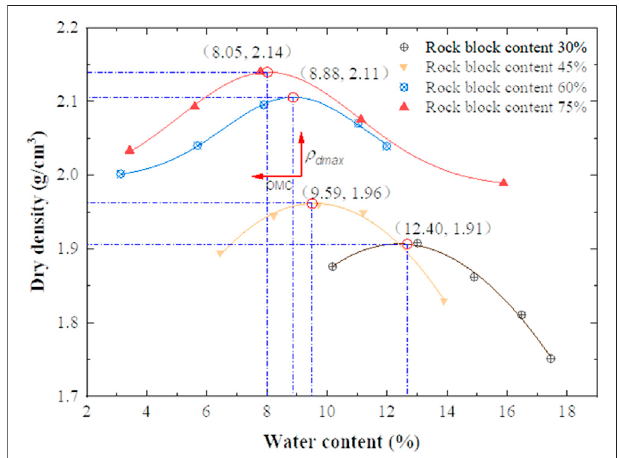
FIGURE 1 | The gradation curves of coarse-grained fi llers used in this study.